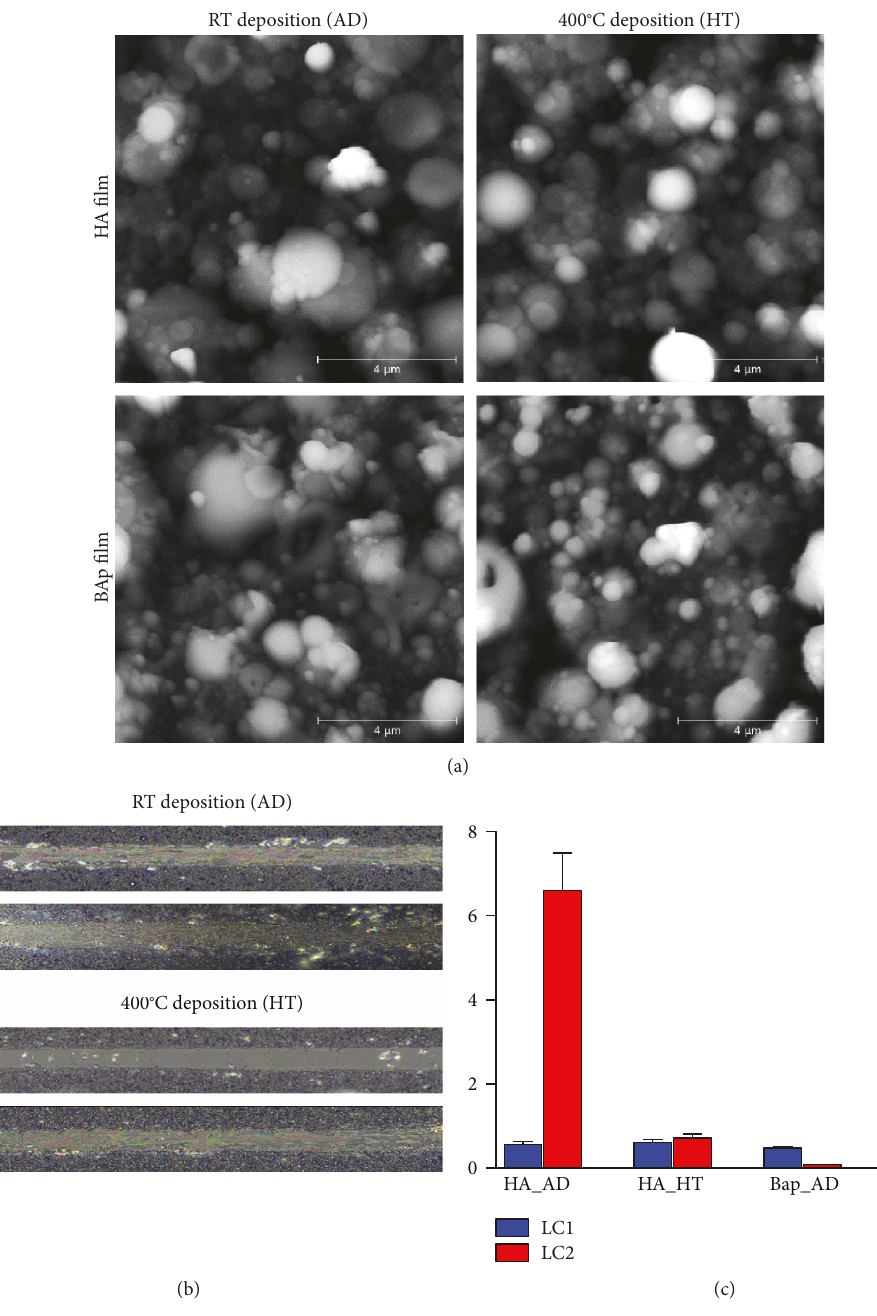
Figure 1: (a) Atomic force microscopy images of the surface of as-deposited and annealed HA and BAp thin fi lms obtained by PED. Worn tracks from 0 to 2N (b) and critical loads LC1 (initial delamination) and LC2 (complete delamination) of HA and BAp fi lms Table 1: Root mean square (RMS) roughness and wettability of deposited fi lms and glass substrate.